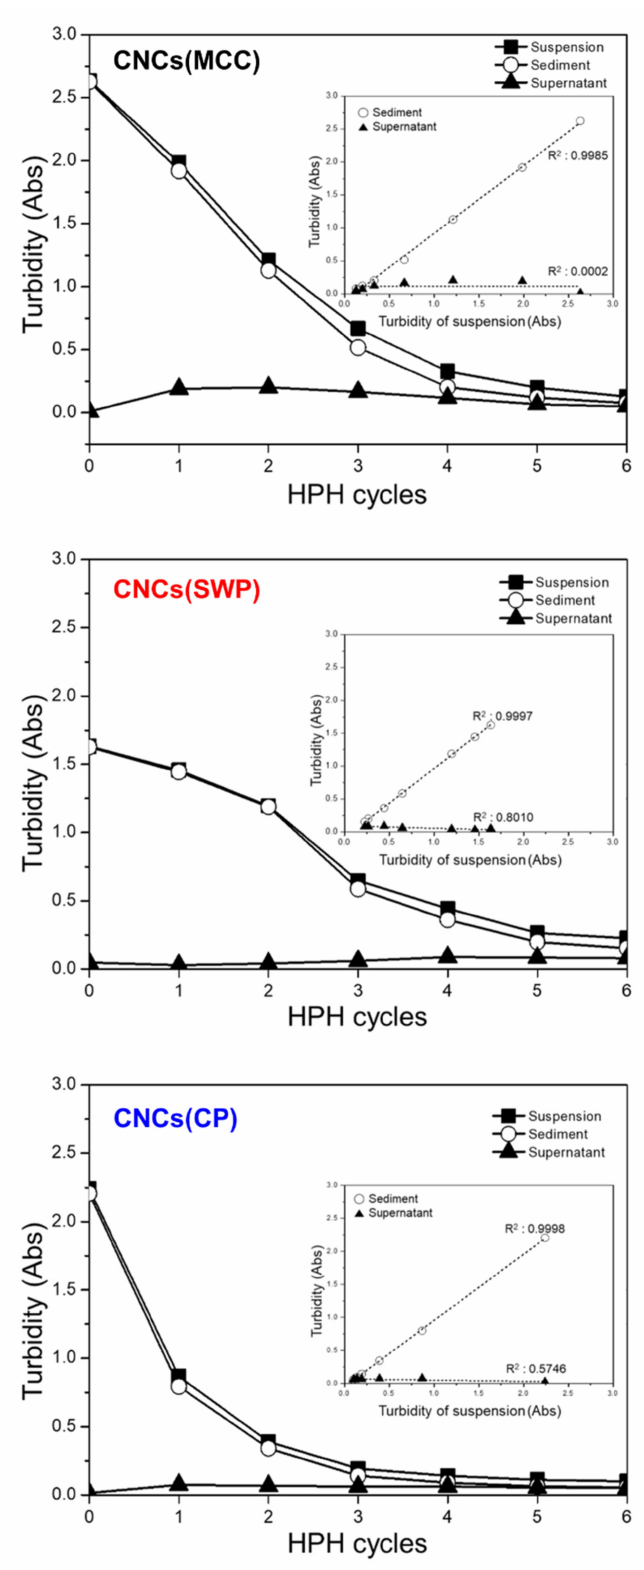
Figure 4. Turbidity curve of the suspension, sediment and supernatant of CNCs dispersions according to number of HPH treatments. (inset) Comparison of the turbidity of sediment and supernatant and the turbidity of the suspension of